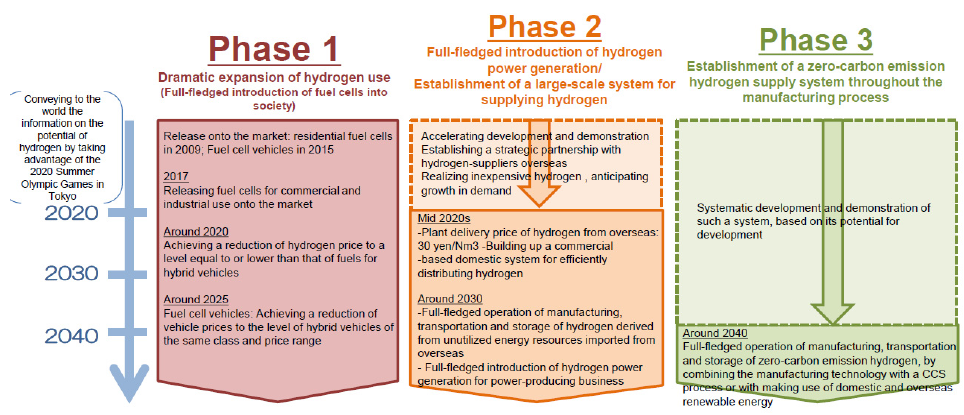
Figure 1. Summary of the strategic road map for hydrogen and fuel cells (redrawn, from METI [15]).